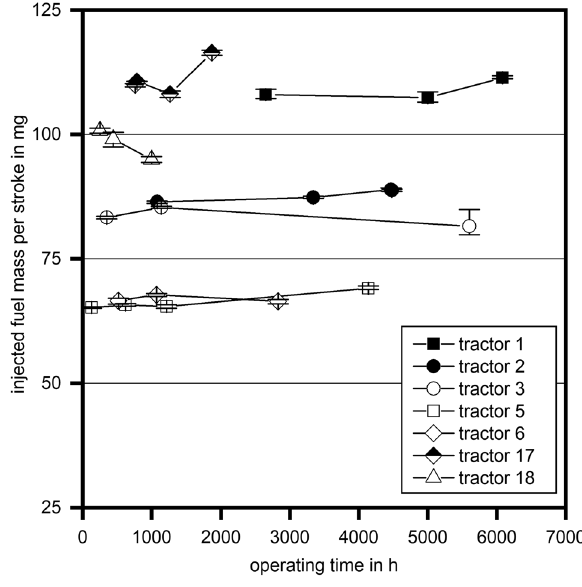
Fig. 7 Injected fuel mass per stroke (arithmetic mean and maxi- mum deviation, n = 3) of the tractors at rated speed and full load at different operating